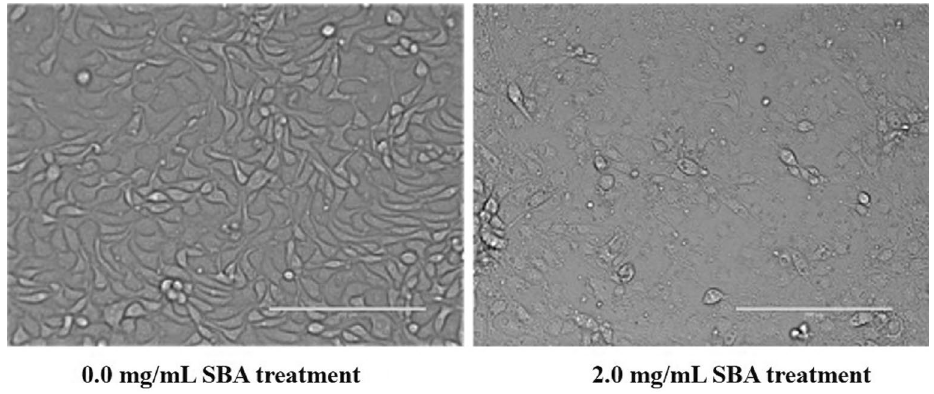
Figure 2. SBA-induced morphological changes of IPEC-J2 cells. IPEC-J2 cell line was cultured with 0.0, or 2.0 mg/mL SBA for 24 h. The cell morphology was observed in different treatments by contrast microscopy at 200 × magnifications.